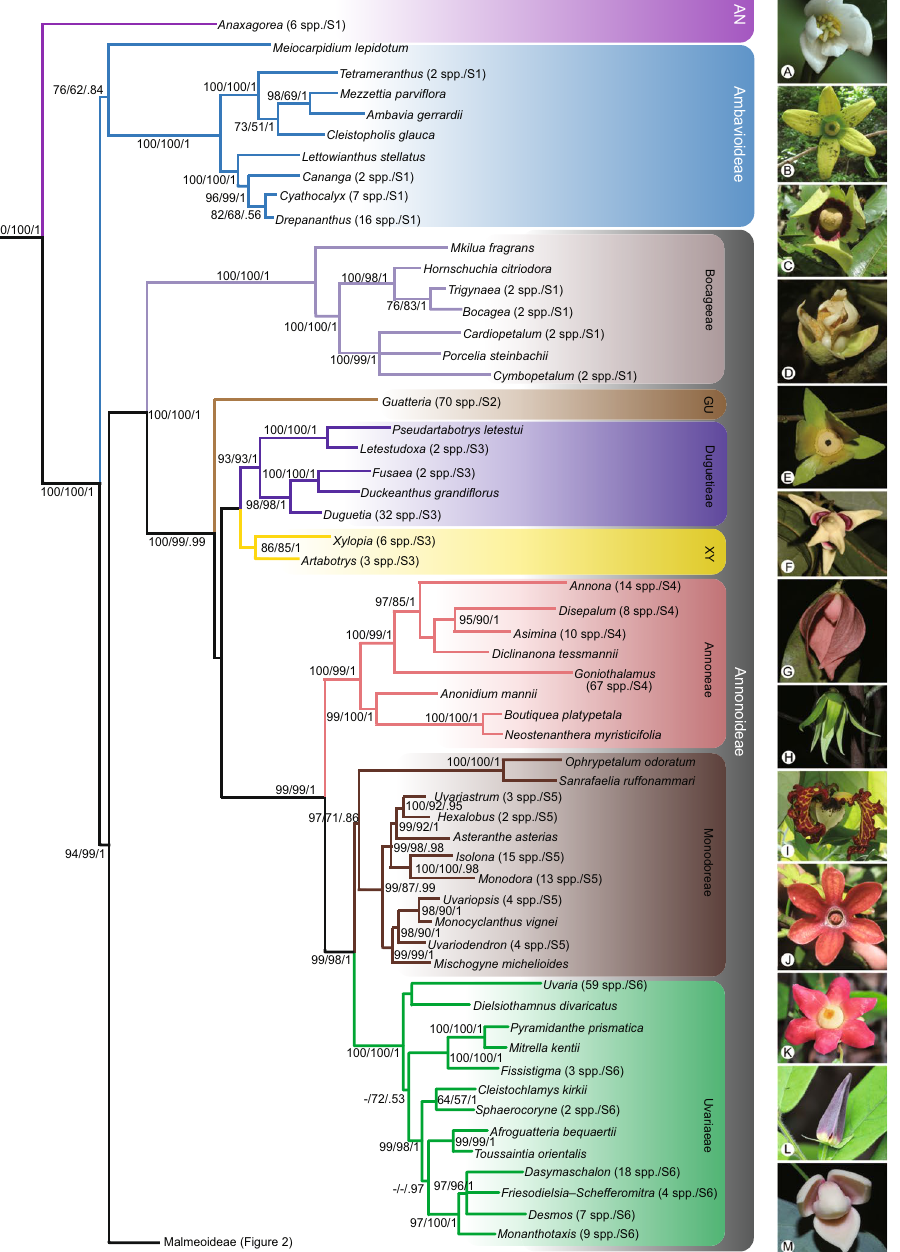
Figure 1. Skeletal representation of the best-scoring maximum likelihood tree inferred from a 754-accession dataset of eight chloroplast markers, showing topology of Anaxagoreoideae, Ambavioideae and Annonoideae. Tips represent genera or subdivisions when genera are not monophyletic. Higher taxon names appear to the right, marked with different background colours. ML bootstrap (BS) values ≥ 50, MP jackknife (JK) values ≥ 50 and Bayesian posterior probabilities (PP) values ≥ 0.5 are indicated at each node: BS /JK/ PP. -, represents clade support values < 50%. Numbers in brackets show numbers of sampled taxon and supplementary figures